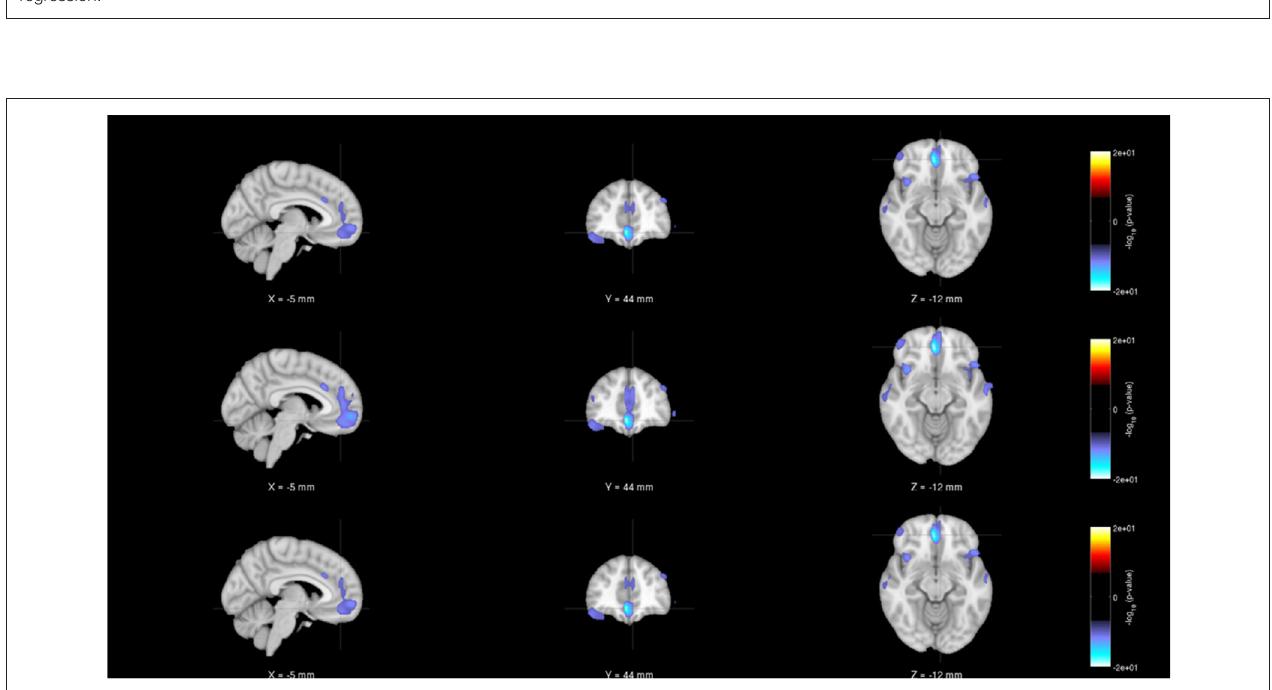
FIGURE 5 | Rendered images of voxel-wise significance values ( − log 10 p -value × sign( t )) for the covariate “Diagnosis” from pooled regression (Top) and single-shot regression (Center) and multi-shot regression (Bottom) overlaid on MNI average template. Regardless of the type of regression performed, the images indicate that in the medial frontal and bilateral temporal lobe/insula there is a significant gray matter density reduction for schizophrenic patients compared to the same regions of the healthy subjects.